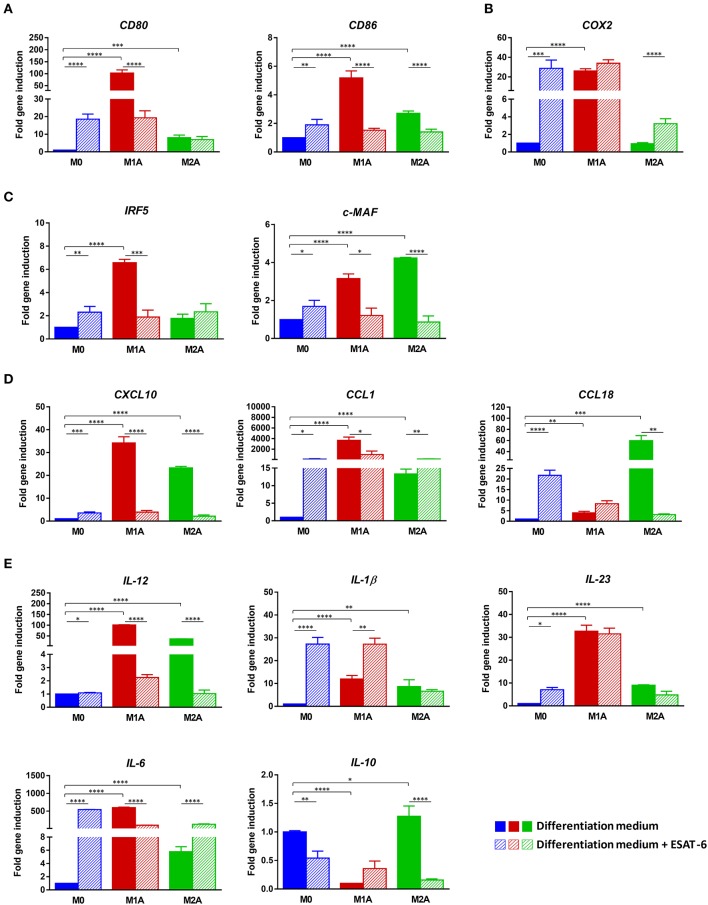
ESAT-6 modulates expression of M1A macrophage markers. RNAs were extracted from the MΦs as indicated in Figure 4 24 h after full activation in presence or absence of ESAT-6. Gene expression levels of (A) Cell surface molecules CD80 and CD86, (B)
COX2, (C) Transcription factors IRF5 and c-MAF, (D) Chemokines CXCL10, CCL1 and CCL18, as well as (E) Cytokines IL-12, IL-1β, IL-23, IL-6, and IL-10 were assessed by RT-qPCR. Data are presented as the mean ±SD of 3 separate experiments (i.e. 3 different donors), each one carried out in triplicate. Asterisks indicate statistical significance (*p ≤ 0.05, **p ≤ 0.01, ***p ≤ 0.001, ****p ≤ 0.0001).